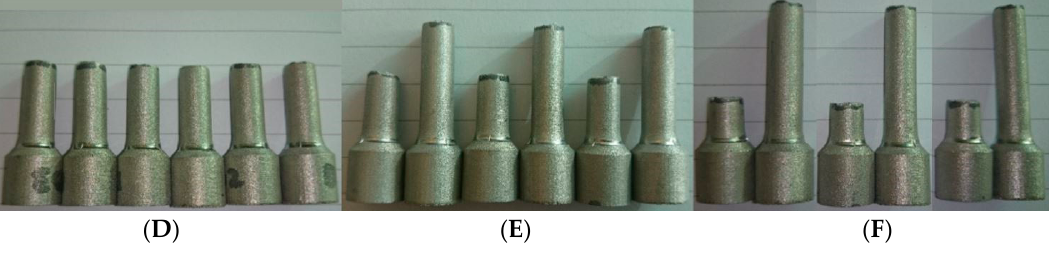
Figure 11. Customised specimen controlled fracture locations ( D – F ).